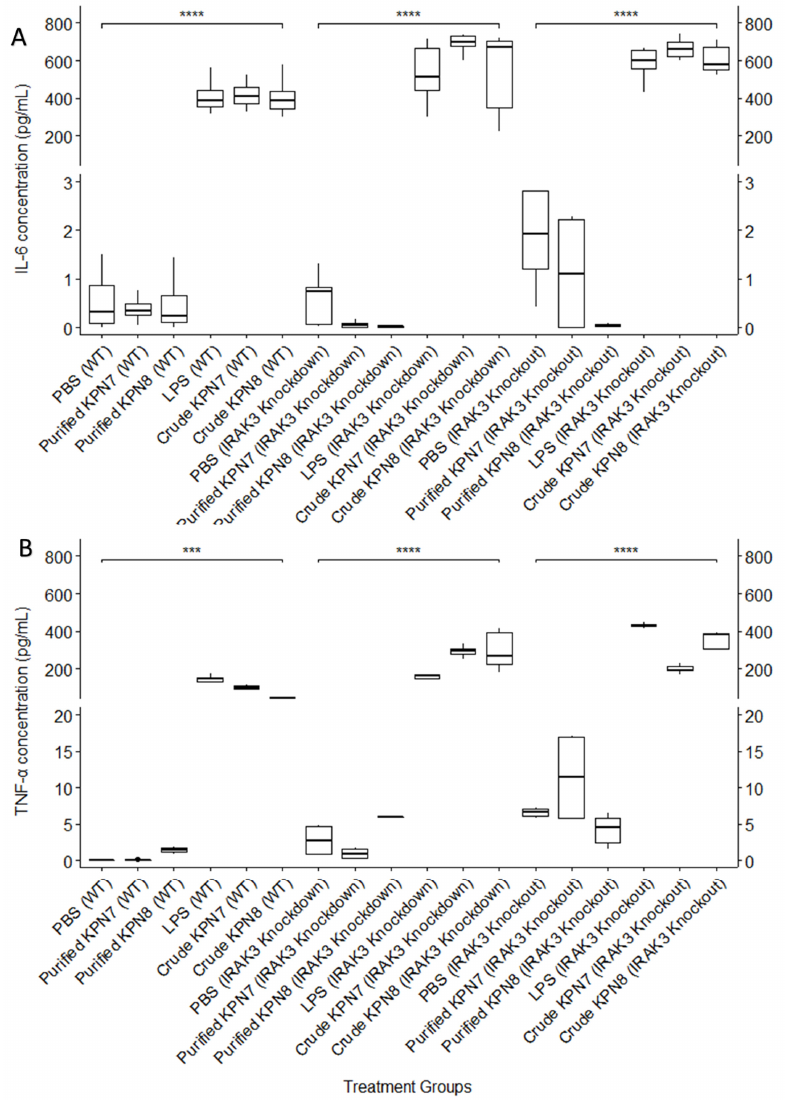
Figure 3. Effects of PBS, LPS (1 µg/mL) and bacteriophage treatments on cytokine production by wild-type (WT), IRAK3 knockdown and IRAK3 knockout THP-1 monocytes. ( A ) Interleukin 6 production ( B ) Tumour necrosis factor alpha production. *** p value <0.001; **** p value <